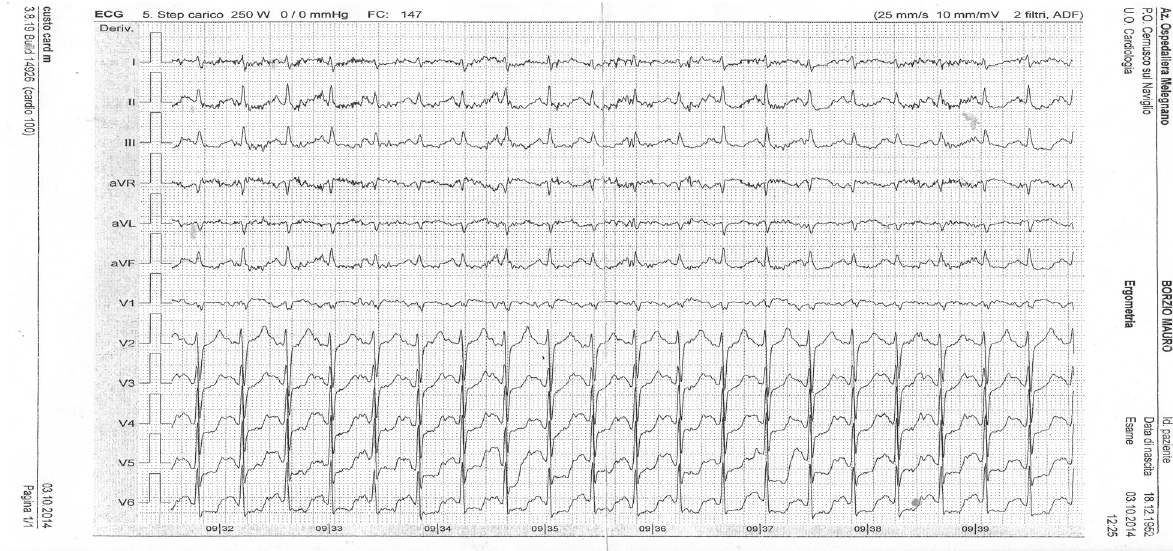
Figure 1. Cardiac exercise stress test showing a 2 mm ST-segment inversion in the anterior leads.